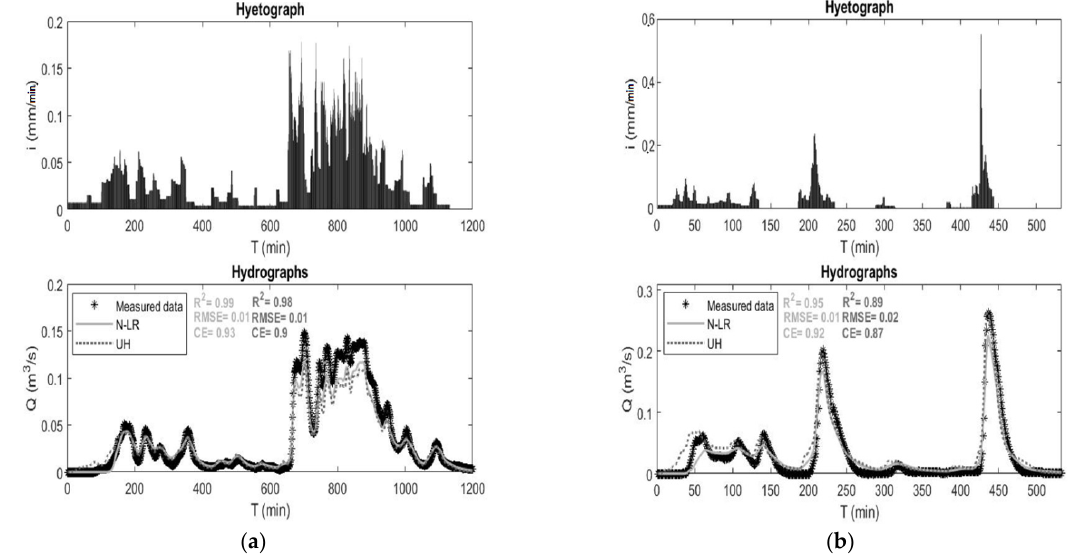
Figure 5. Hyetographs (top) and comparison of the hydrographs (bottom) for N-LR (gray solid line) and UH (dark-gray dotted line) models with measured data (star symbol) for: ( a ) event 23 (from calibration set); and ( b ) event 12 (from validation set).